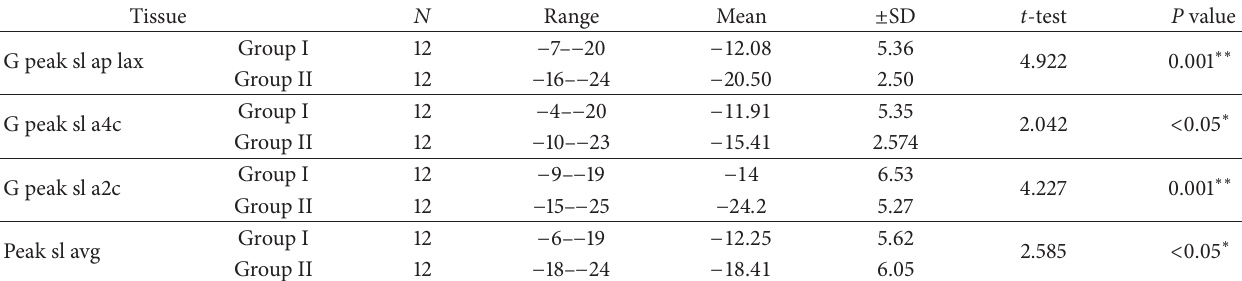
Table 5: G-peak sl ap lax, G peak sl a2c, G peak sl a4c, and G peak sl avg in group I and group